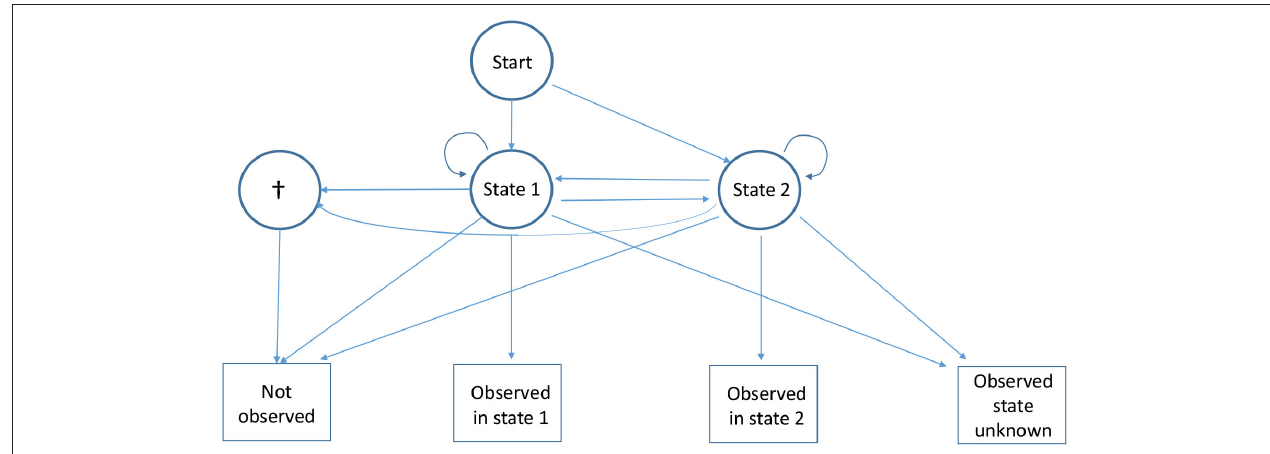
FIGURE 1 | Diagram of the capture recapture multievent model for partial observations with two observable live states under the null hypothesis. The state “dead” is represented by †. Four events are generated by the three states: “Not observed,” which is obligatory for the state “dead”; two complete observations, “Observed in state 1” and “Observed in state 2”; and the partial observation “Observed state unknown,” which may be generated by either live state.